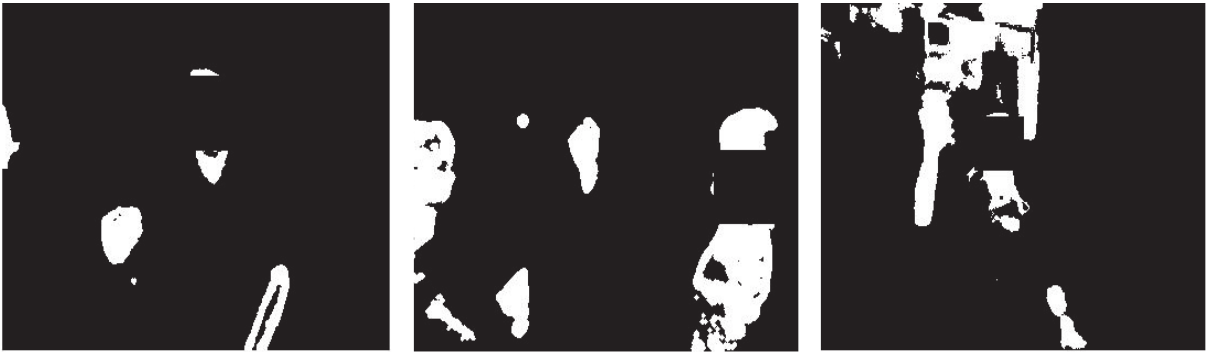
Figure 9: Sample of skin segmentation after removing face